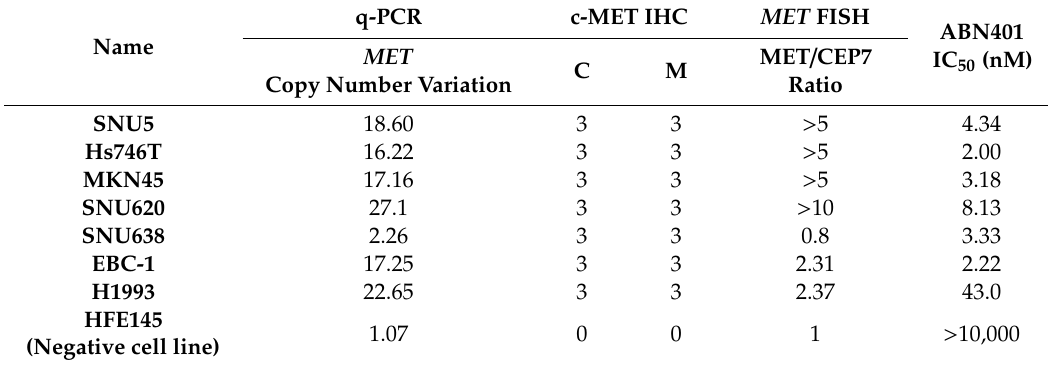
Table 1. MET status and IC50 value of ABN401 in MET -addicted cell